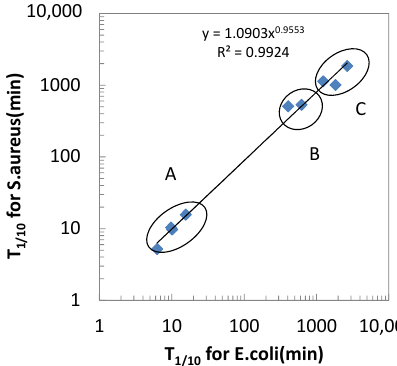
y = 1.0903x 0.9553 R² = 0.9924